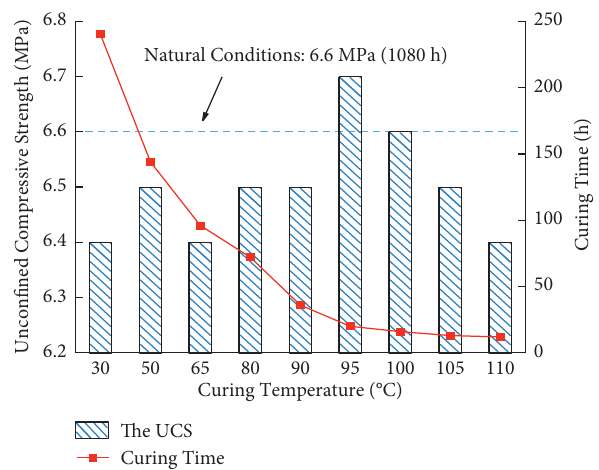
Figure 8: Unconfined compressive strength at different curing temperatures.